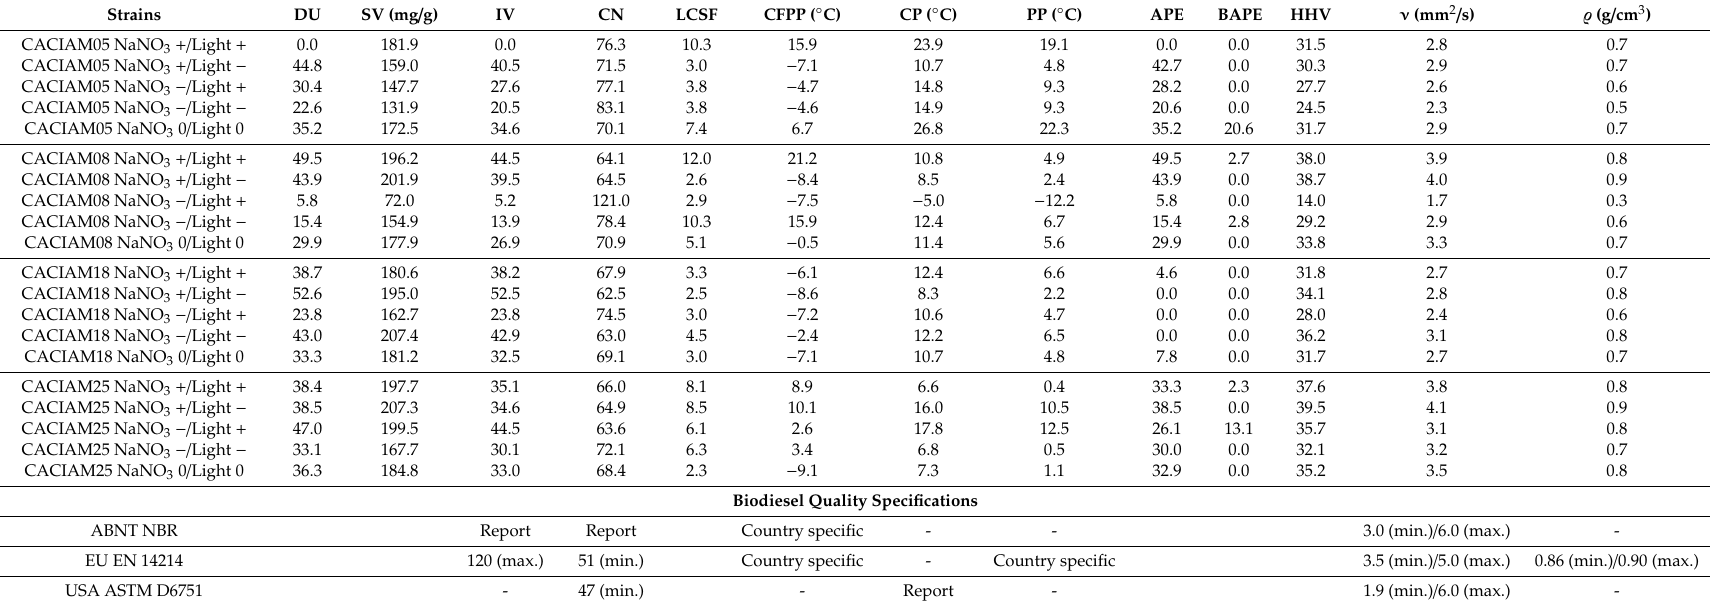
Table 3. Empirical parameters of biodiesel quality based on the fatty acid profile and specifications based on Brazilian, European and United States (US) standards. Strains DU CACIAM05 NaNO 3 +/ Light +